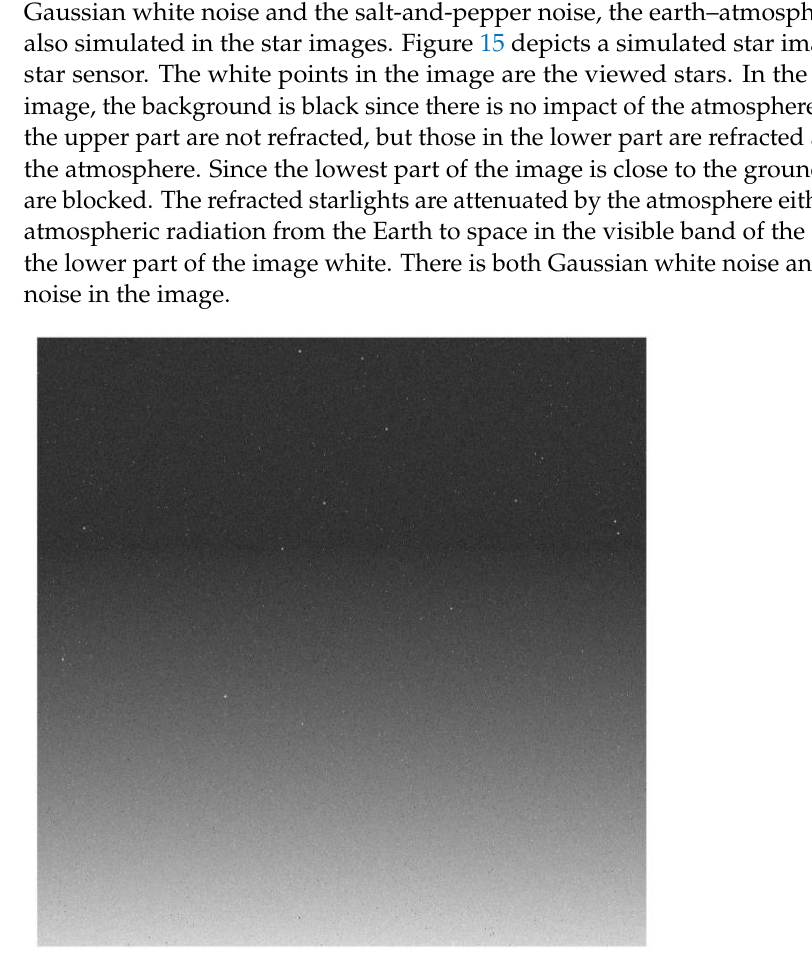
Figure 15. Simulated star image output by the star sensor. The simulated images were processed to acquire the refraction angle. Both the refraction angle and the satellite position were used to retrieve the stratospheric density. Figure 16 depicts the relative error of the retrieved density with the tangent height by the Monte Carlo simulation. In total, 10,000 simulations were run to acquire the 10,000 relative error curves in Figure 16. The RMS values were also plotted in Figure 16. Figures 17 and 18 depict the retrieved density with the tangent height and its relative error in one simulation, respectively. In Figure 16, the relative error of the retrieval increases as the tangent height increases. The RMS value of the error of the retrieval is 0.9% at the tangent height of 30 km, while it is about 4.5% at the tangent height of 40 km. In Figures 17 and 18, the relative error of the retrieval also increases with the increase of the tangent height, which coincides with the result in Figure 16.